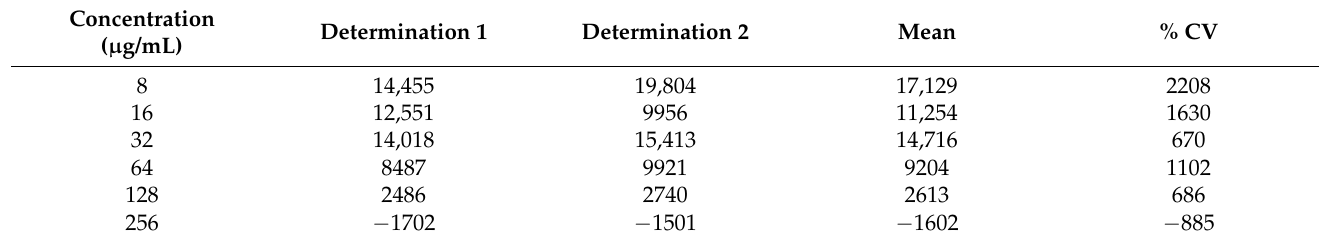
Table 3. Antiproliferative activity of compound 20 on A549 lung cell